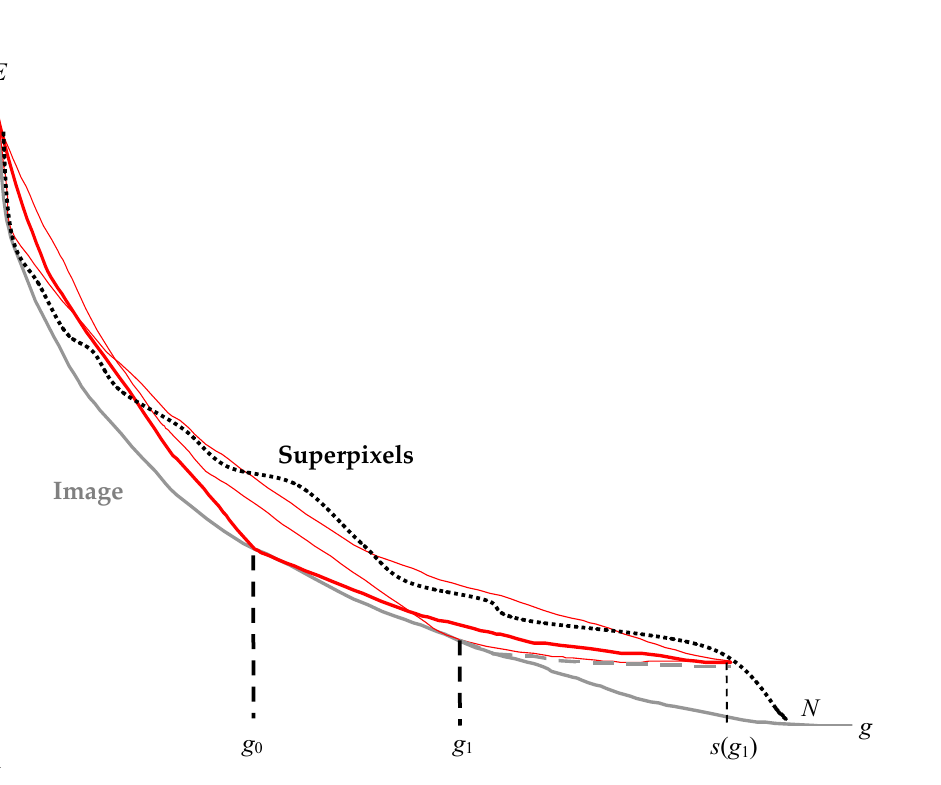
Figure 6. Model of hierarchical approaching of optimal approximations. The limiting lower gray curve, assumed to be predominantly convex, describes the optimal image approximations. The bold red convex curve tangent to the gray curve at g = g 0 describes the target hierarchy of image approximations. Another thin red convex curve tangent to the gray curve describes the target hierarchy of approximations at the maximum value g 0 = g 1 . The rest upper thin red convex curve describes the hierarchy of approximations produced by Ward’s original method. The dotted black curve describes the hierarchy of superpixel approximations or enlarged pixels intended to initialize Ward’s pixel clustering.